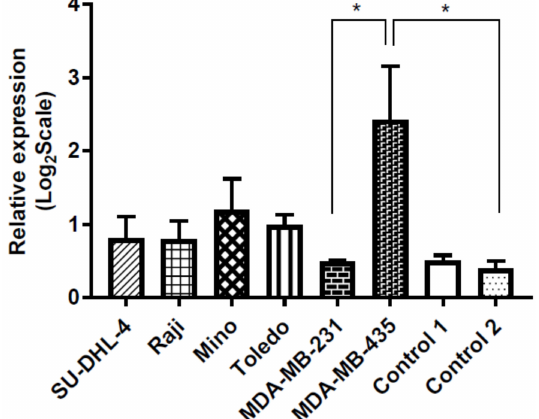
Figure 2. Hexokinase 2 ( HKII ) gene expression . q-PCR analysis of HKII mRNA transcript expression in NHL (SU-DHL-4, Raji, Mino, Toledo), breast cancer (MDA-MB-231) and melanoma (MDA-MB-435) cell lines as compared to healthy controls 1 and 2. HKII mRNA levels were increased in NHL cell lines compared to breast cancer cells and healthy controls, however expression levels were not significantly different. HKII mRNA levels were significantly increased in the melanoma (MDA-MB-435) cells when compared to breast cancer cells (MDA-MB-231) ( p = 0.044), healthy control 1 ( p = 0.045) and 2 ( p = 0.037), but not significantly increased compared to the NHL cells. Relative expression normalized to 18S , error bars = SEM and statistical significance calculated using paired Student’s t -test and defined as: * p <